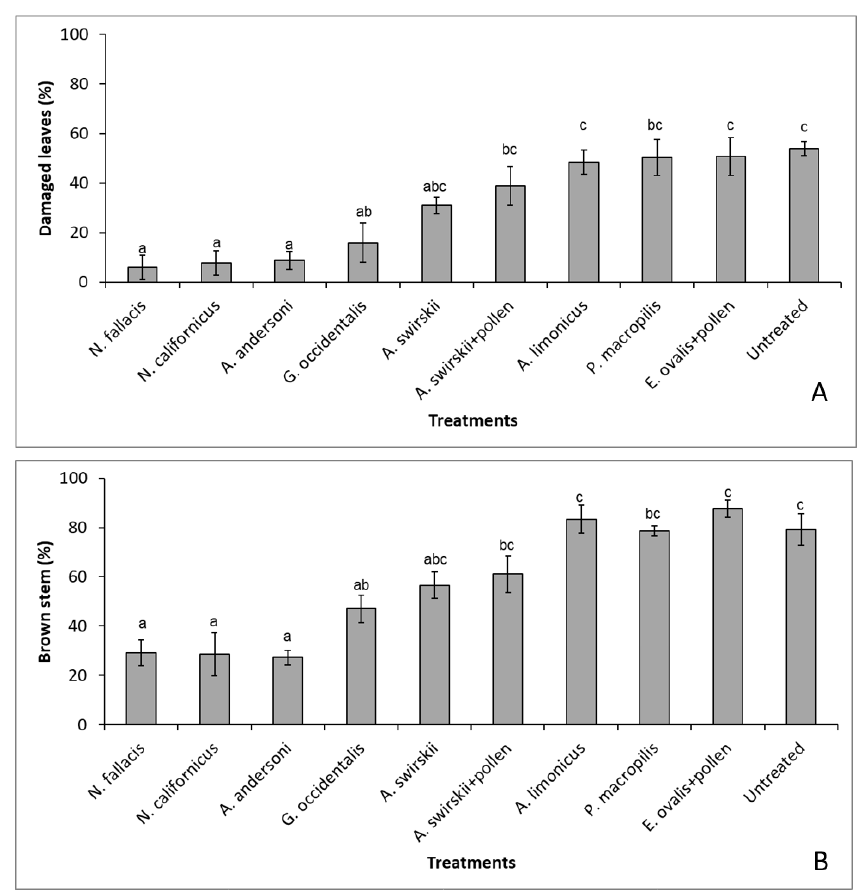
Figure 1. Percentage of damaged leaves ( A ) and brown stem ( B ) (mean ± SE) caused by TRM on the tomato plants of the different treatments six weeks after TRM inoculation and following four weekly curative releases of 500 predators per plant. Different letters above the data points denote significant differences among treatments after the generalized linear model ( p < 0.05).